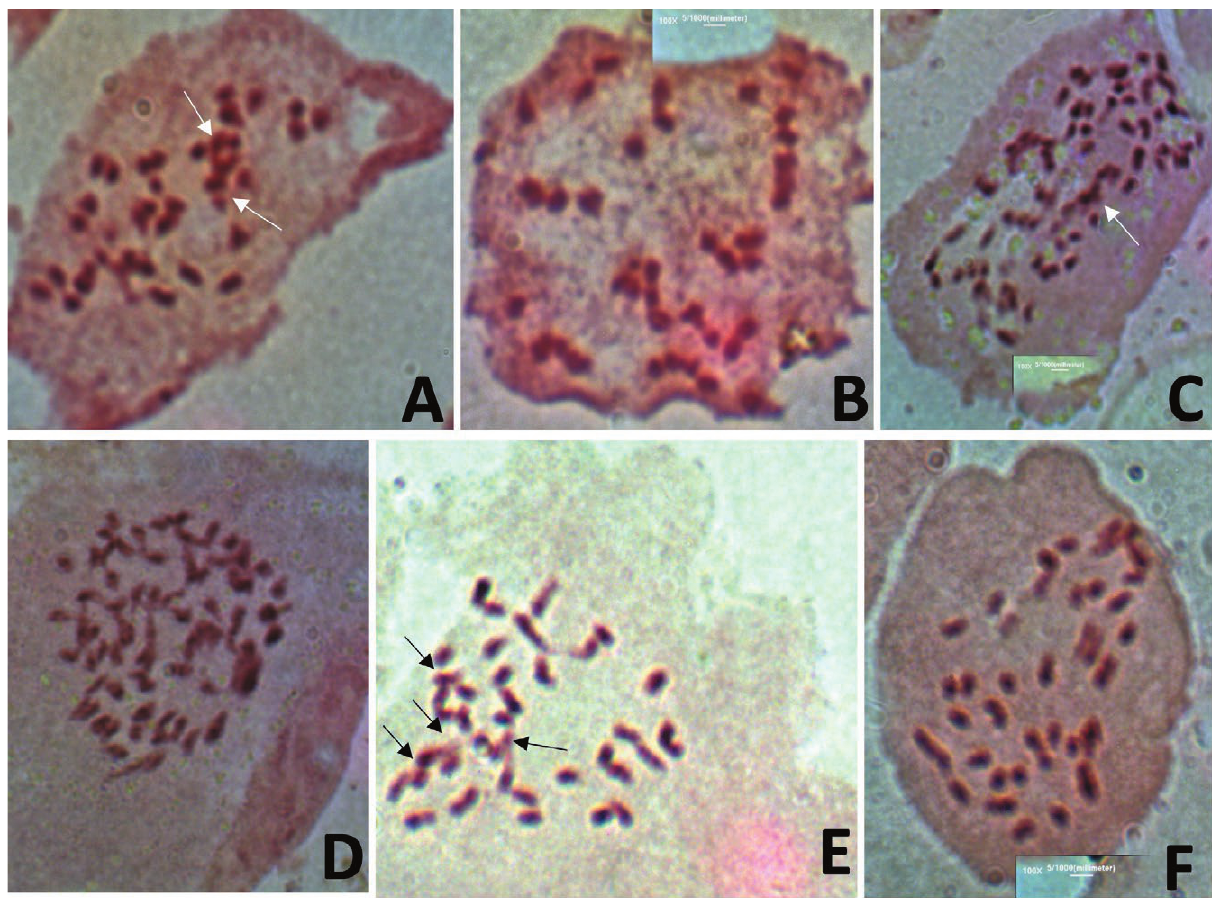
Figure 2. Mitotic metaphase spreads in the Dioscorea species studied. A. D. alata (Ewura), 2n = 32 (Arrows show mitotic chromosome overlaps); B. D. alata (Ewura), 2n = 32; C. D. cayenensis (Igangan), 2n = 68 (Arrow shows mitotic chromosome overlap); D. D. cayenensis (Igangan), 2n = 68; E. D. rotundata (Ikumo), 2n = 38 (Arrows show mitotic chromosome overlap); F. D. rotundata (Ikumo), 2n =